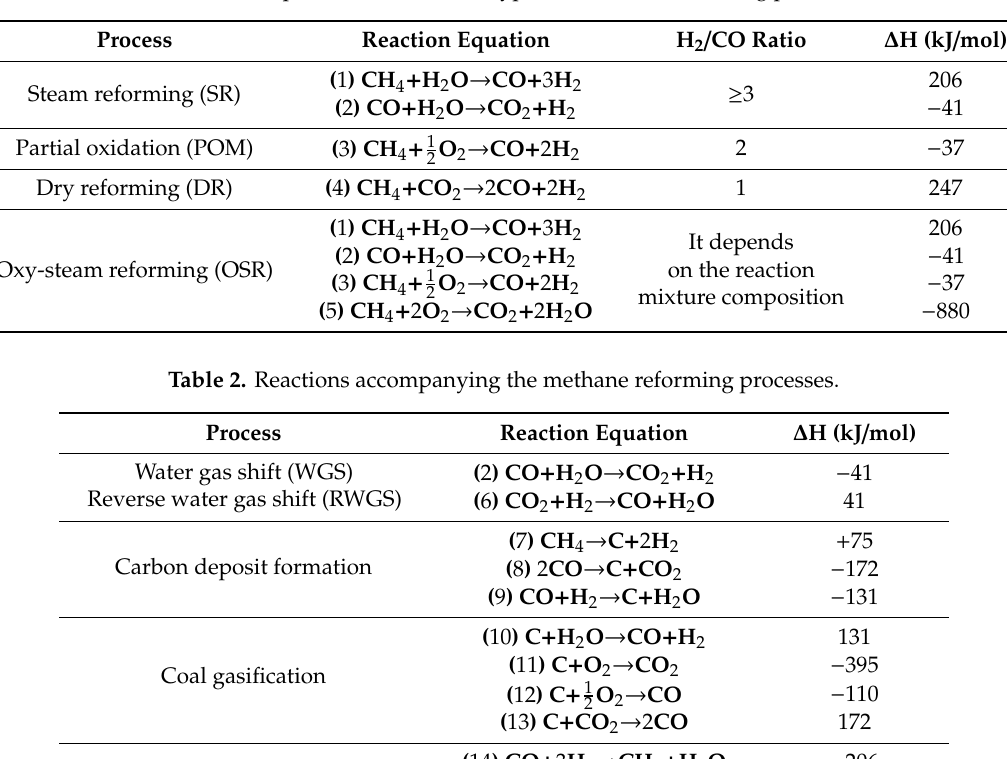
Table 1. Description of the di ff erent types of methane reforming processes.